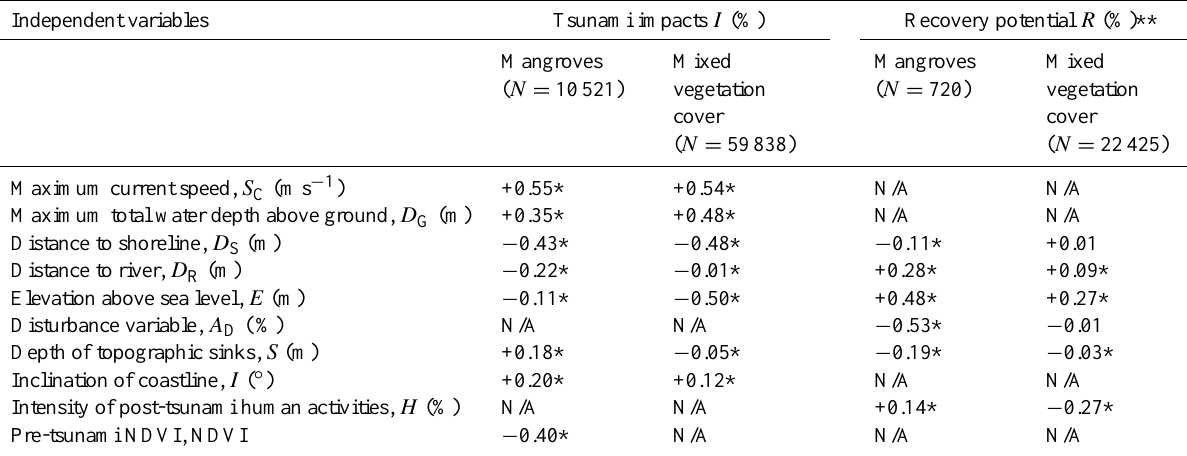
Table 8. Correlation coefficients calculated for the tsunami impacts and recovery potential Independent